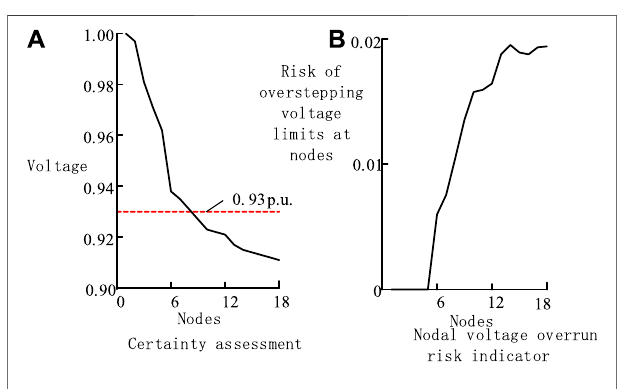
FIGURE 7 | Results of deterministic assessment and proposed short-term safetyriskindicator: (A) Certaintyassessment. (B) Nodalvoltageoverrunriskindicator.